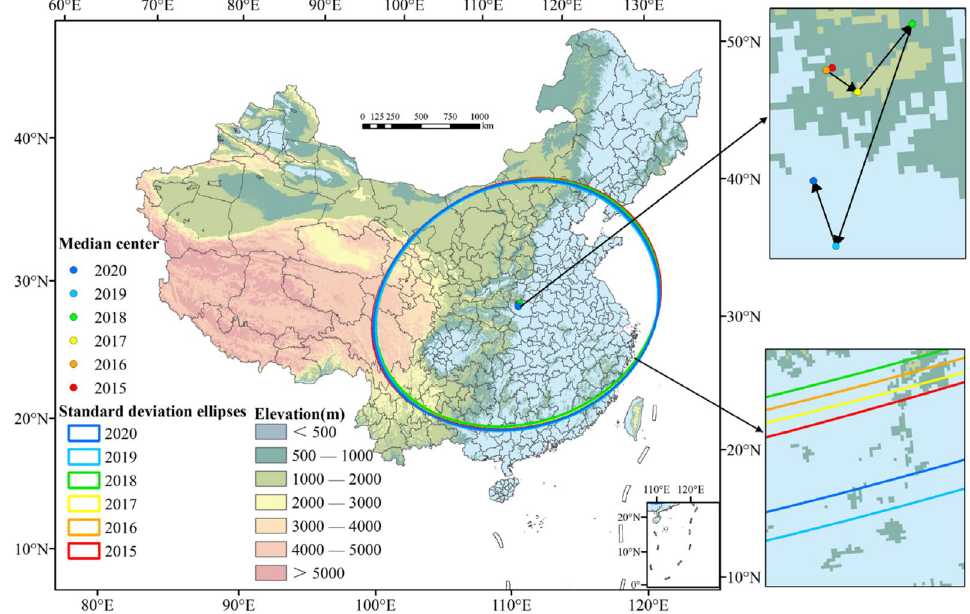
Figure 5. Time series of the mean center and standard deviational ellipse of the O 3 concentration in mainland China in 2015–2020. (Note: Urban O 3 concentrations are derived from the average values of the effective monitoring stations in each city).